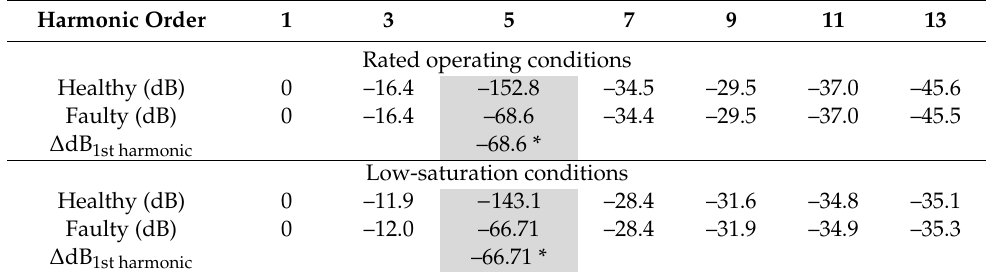
Table 3. Line current harmonics. Amplitudes of the harmonics under healthy and faulty conditions with only one shorted turn.